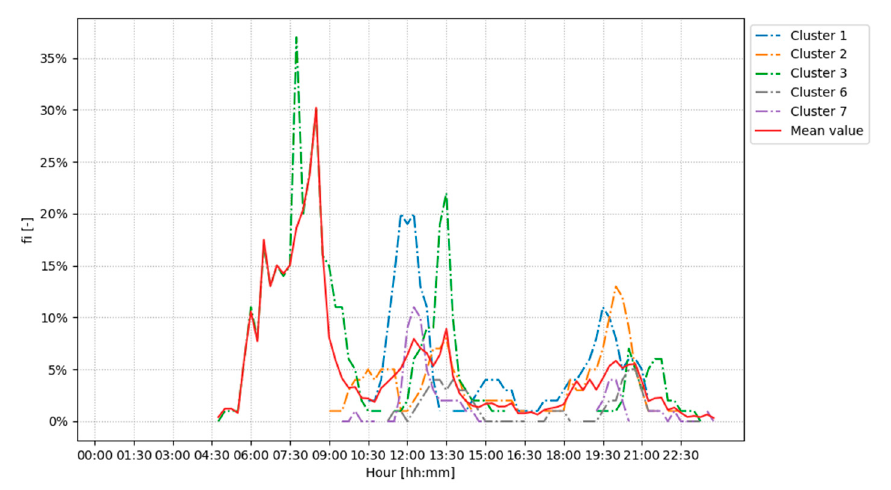
Figure 11. Daily usage probability: Ovens.